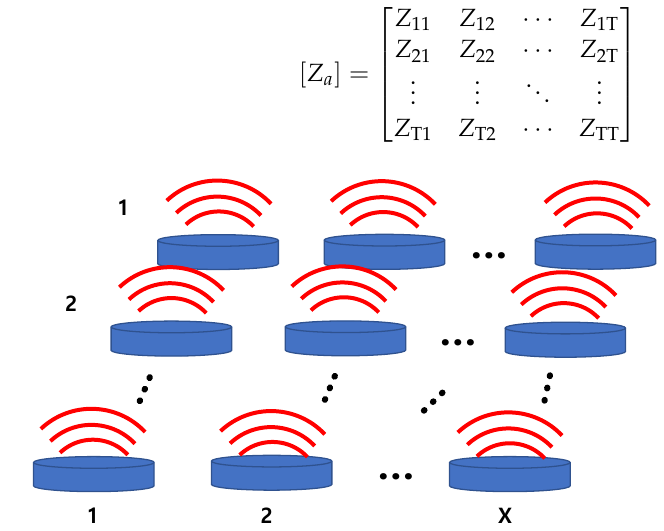
Figure 7. Sound radiation by an X × Y array of transducers with a single radiation surface.